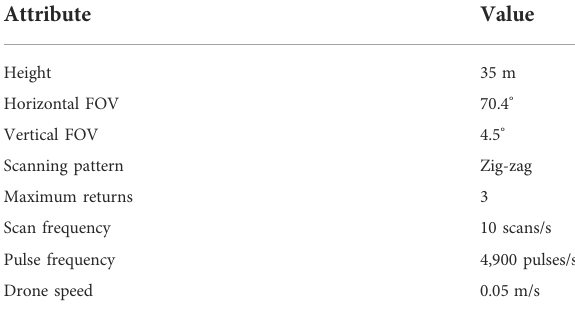
TABLE 1 Con fi guration of the virtual ALS sensor for scanning the synthetic trees, following the speci fi cations of a DJI Zenmuse L1